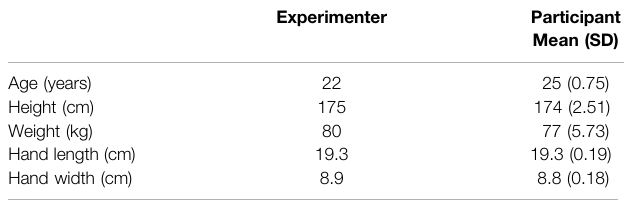
TABLE 1 | Experimenter and Participants Data.